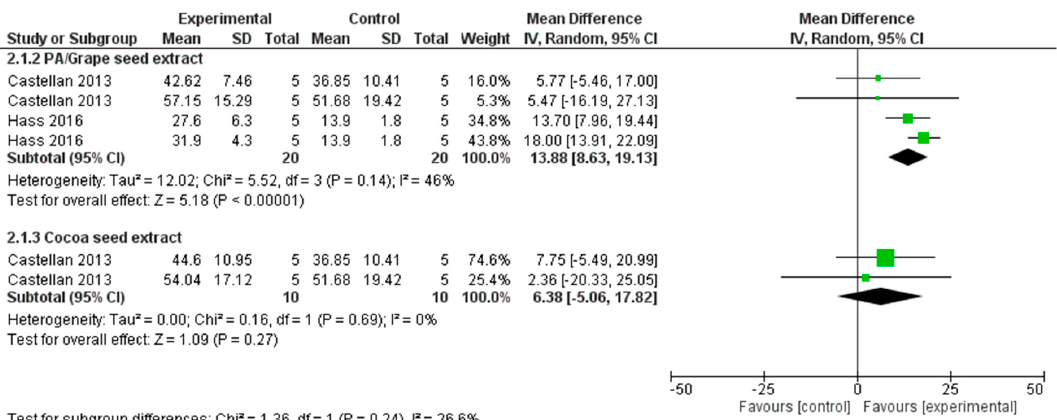
Figure 4. Forest plot analysis of studies with 12 months of ageing (>1 year).